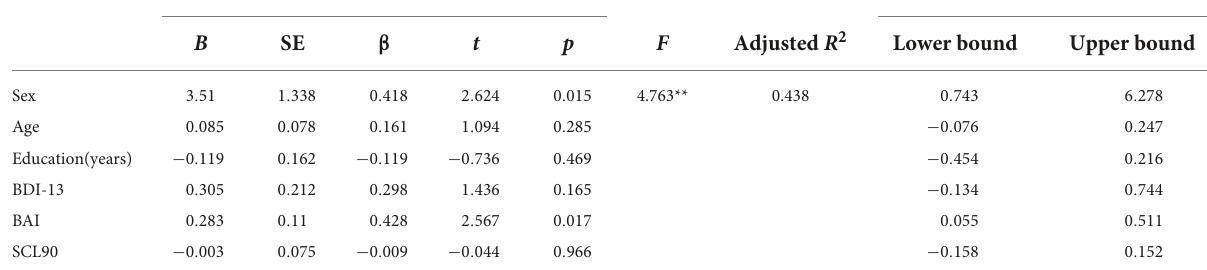
TABLE 3 Multivariate linear regression to predict sleep